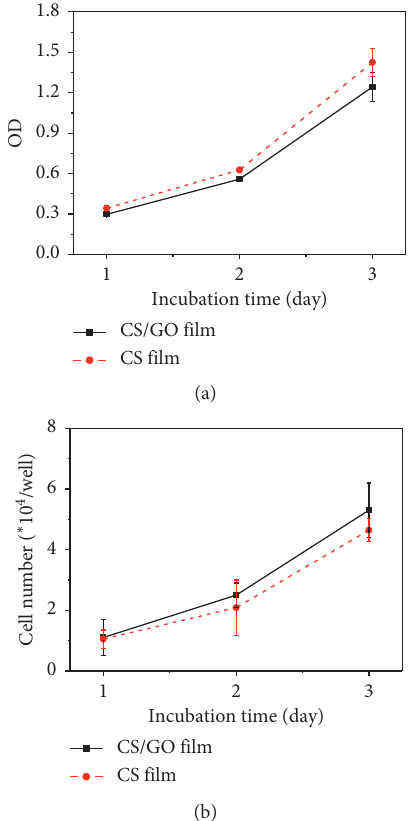
Figure 6: Cell viability (a) and cell number (b) as a function of incubation time on CS/GO films and CS films. ∗ p < 0 . 05 and ∗∗ p < 0 .